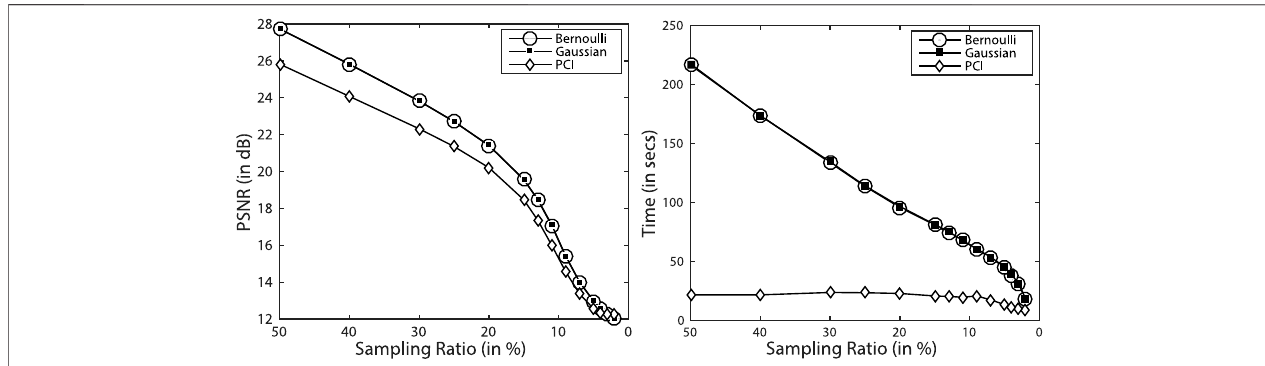
FIGURE 8 | Reconstruction accuracy (A) and time complexity (B) with different measurement matrices for the data set “ Urban. ” db-D is used as the sparsifying basis to generate these results. Reported values are obtained by averaging values across all the bands. PCI provides similar SNR but with signi fi cantly reduced time